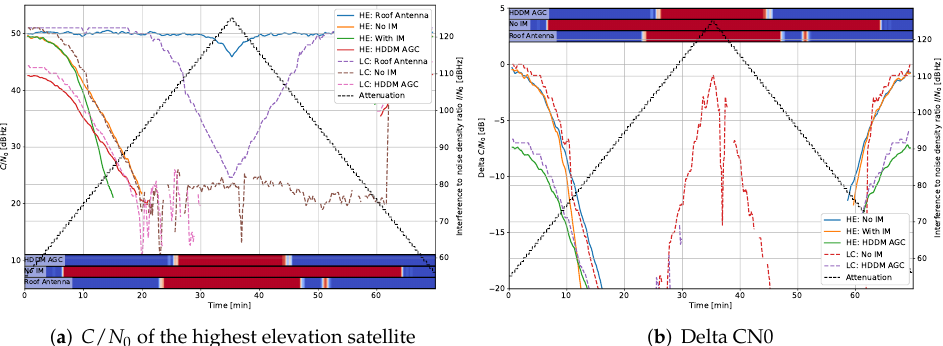
Figure A15. Interference #6: Filtered noise with 4MHz bandwidth with Galileo